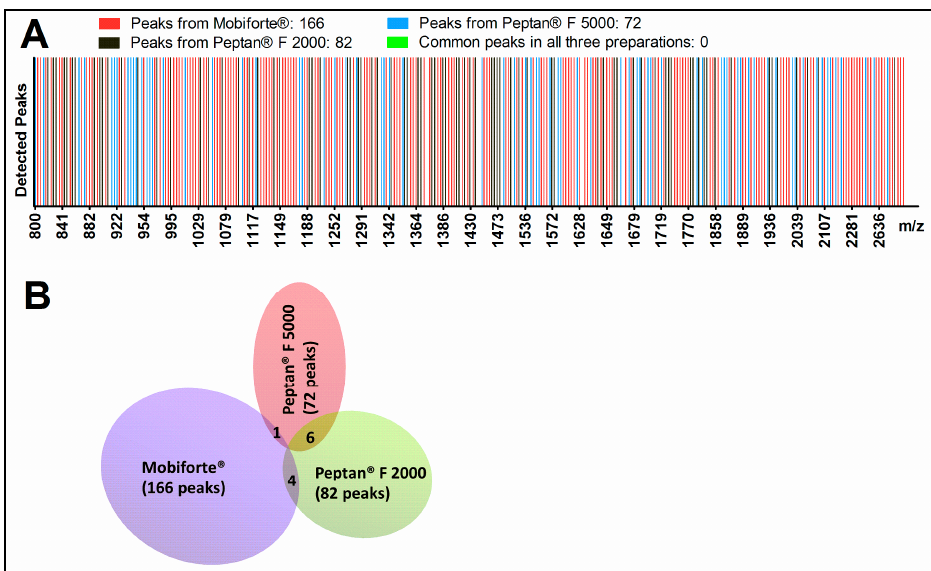
Figure 1. Mass spectra from CHs by MALDI-TOF-MS. Representation of mass spectra from Mobiforte ® , Peptan ® F 5000 and Peptan ® F 2000 as a ( A ) gel-like view; and ( B ) Venn diagram. MALDI-TOF-MS analysis was performed in reflector mode with a mass-to-charge ratio ( m / z ) range between 500 and 4000 m / z using mass gates. The numbers in brackets are the number of total peaks each representing a peptide of each CH. The numbers in the intersections of the Venn diagram are peptides shared by both preparations. No common peptide was identified in all three CHs.